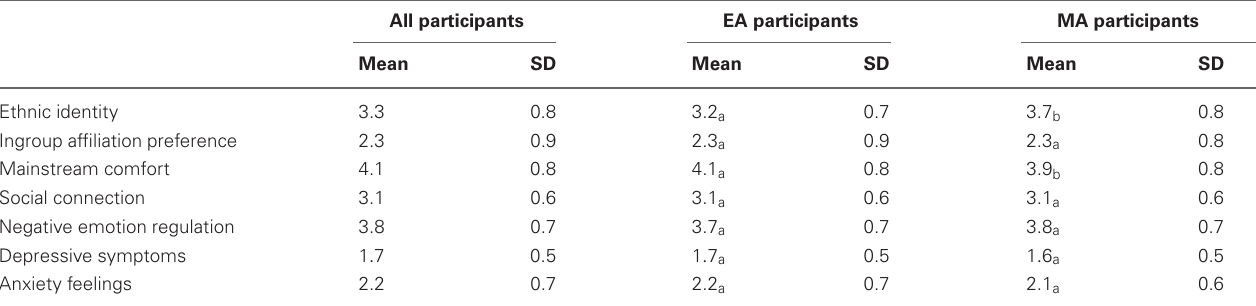
Table 1 | Means and standard deviations for study variables among all participants, non-Hispanic White/European American (EA) participants, and Mexican/Mexican American (MA)